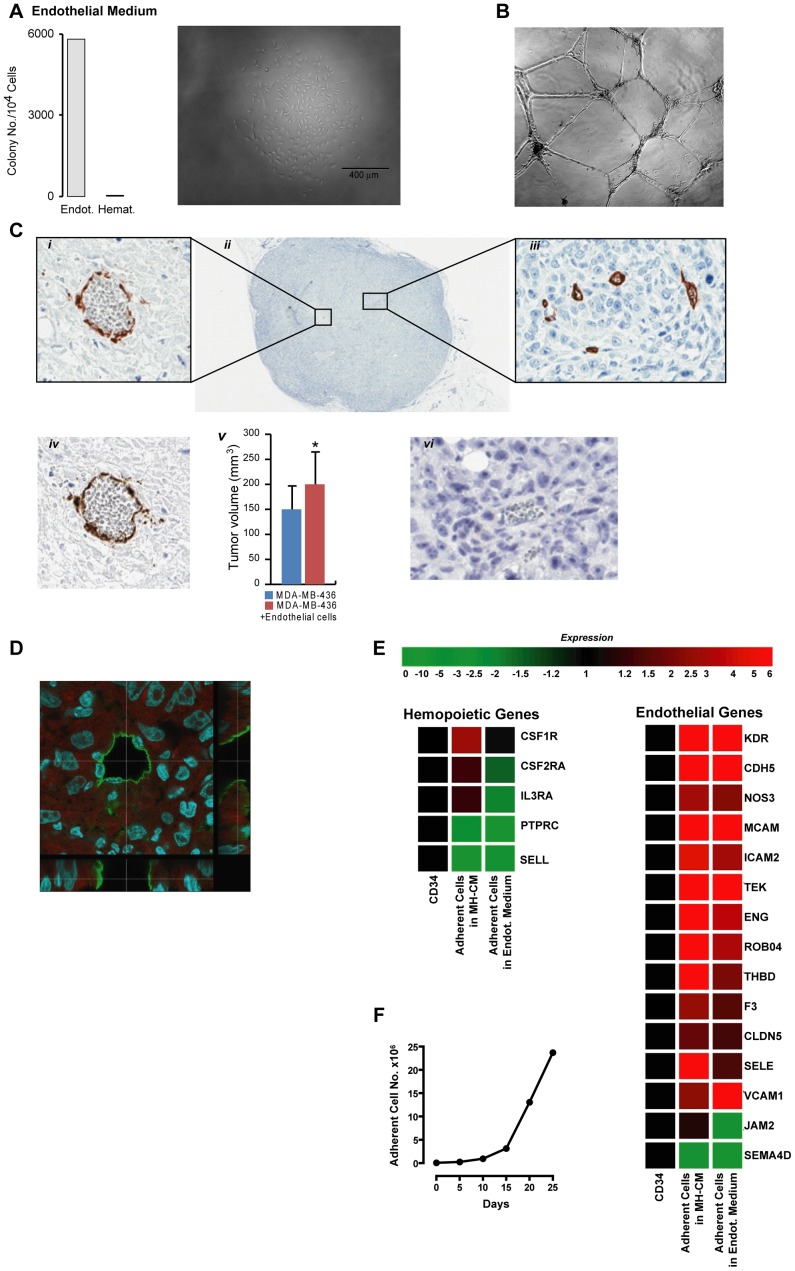
Functional characterization of adherent cells in MH-CM culture.A- left panel -Clonogenetic assay of adherent cells generated by CD34+ cultured in MH-CM for 30 days, carried out in semi-solid culture supplemented with the indicated medium. Right panel - Light microscopy image of a single cell-derived colony grown in semi-solid EGM2 endothelial medium. A representative experiment out of 5 is shown. B-Phase-contrast morphology of adherent cells cultured on matrigel supplemented with EGM-2 for 12 hours (original magnification 10x). A representative experiment out of 5 is shown. C- Immunohistochemistry evaluation of adherent cells, generated by CD34+ cultured in MH-CM for 30 days, engrafted in breast cancer-bearing NSG mice (n = 5). Human CD34 (i,ii,iii) and human CD31 (iv) detect functional vessels containing red blood cells. These antibodies are human-specific and do not cross react with mouse vessels (vi). A representative experiment out of 5 is shown. (v) Tumor volume quantification showing that the volumes of tumors where breast cancer cells were co-injected with the adherent cells generated by CD34+ cells are significantly higher (* p<0.04) than the volume of tumors where breast cancer cells alone were injected in NSG mice (n = 5/group). D-Confocal laser-scanning of human CD34 antigen distribution in a tumor section of a MB-MDA436 plus adherent cells, generated by CD34+ cultured in MH-CM for 30 days. Images were acquired using a Leica TCS SP5 confocal microscope and sequential Z-stacks were performed using a 63×1.4NA oil immersion objective, zoom 3X, 0.3 µm z step. Snapshot images are orthogonal sections of the z-stacks taken at points along the vessel’s cavity. A representative picture of one tumor out of 5 is shown. E- Expression levels of haemopoietic and endothelial marker genes obtained from microarray analysis of fresh CB CD34+ cells (CD34), the adherent cellular progeny obtained after 53 days of culture in MH-CM (Adherent Cells in MH-CM) and this adherent cellular progeny grown in endothelial medium (EGM2) for additional 7 days (Adherent Cells in Endot. Medium). Expression values were normalized using CD34+ cells as control. A global up-regulation of endothelial marker genes was observed in adherent cells grown in MH-CM, both prior to and after instruction by EGM2, whereas haemopoietic markers were either unvaried or down-regulated. A representative analysis out of 3 is shown. F- Growth curve of the adherent cellular progeny obtained from CB CD34+ cells grown in MH-CM when transferred into EGM2 endothelial medium. A representative experiment out of 10 is shown.